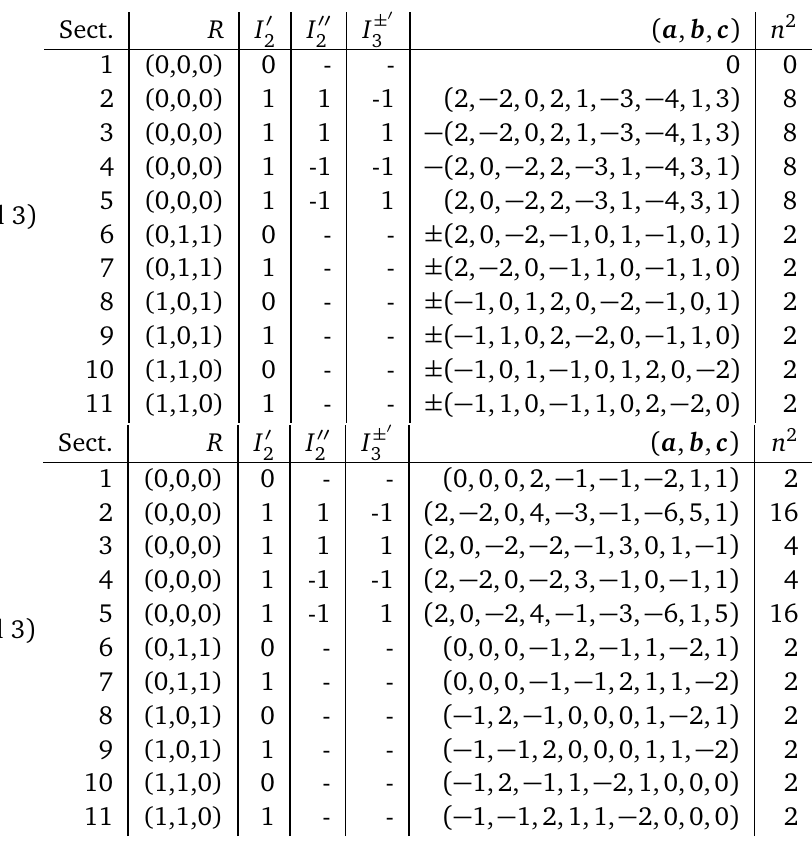
= 0) into 11 subsectors conserved by Table 1: The splitting of the even sector ( I 1 dynamics II and classified by the imposed “parity control” R and the nontrivial in- (cid:48) variants I (cid:48) , I (cid:48)(cid:48) , I ± , for L = 0,1 ( mod 3 ) (for L = 2 ( mod 3 ) , change all signs in 2 2 3 ( a , b , c ) of L = 1 ( mod 3 ) ). Examples of configurations ( a , b , c ) , (with the smallest (cid:80) ( a 2 + b 2 + c 2 ) ) are norm n 2 = 1 i = x , y , z 6 i i i